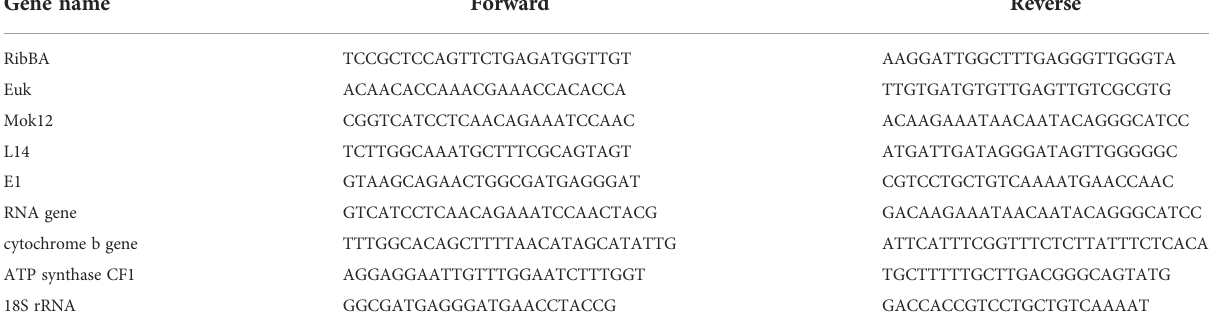
TABLE 2 ChIP-qPCR